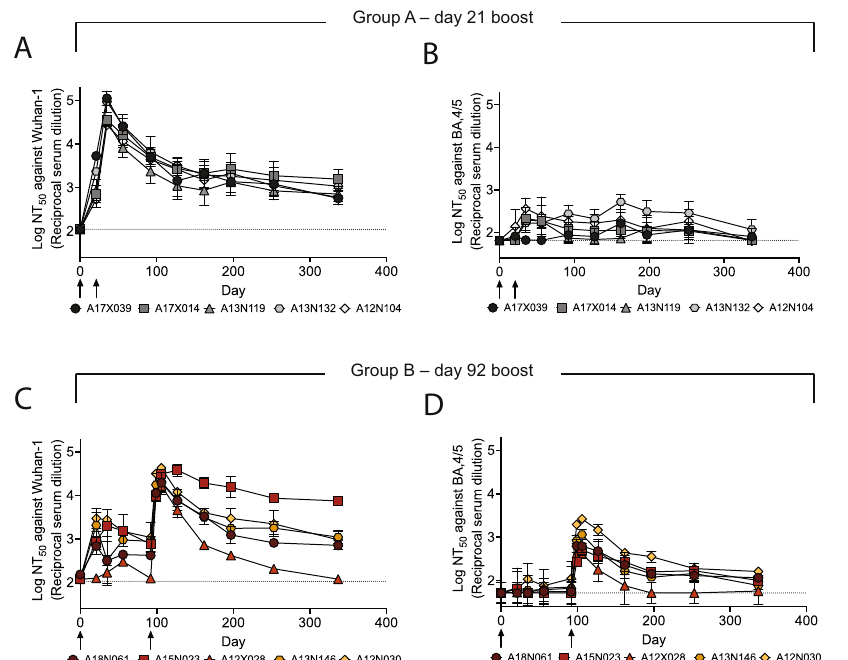
Fig. 4 | DCFHP-alum immunized NHPs elicit long-lived immunity against both Wuhan-1 and BA.4/5 pseudoviruses. A Serum neutralizing titers were monitored over 337 days against Wuhan-1 SARS-CoV-2 pseudovirus for animals in group A; daysofprimeandboostindicatedwitharrows. B Asinpanel( A )butagainstBA.4/5 pseudovirus. C , D As in panels ( A ) and ( B ) but with group B NHPs, respectively.